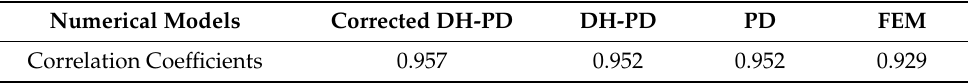
Table 4. Correlation coefficients between the test and numerical results on the crack